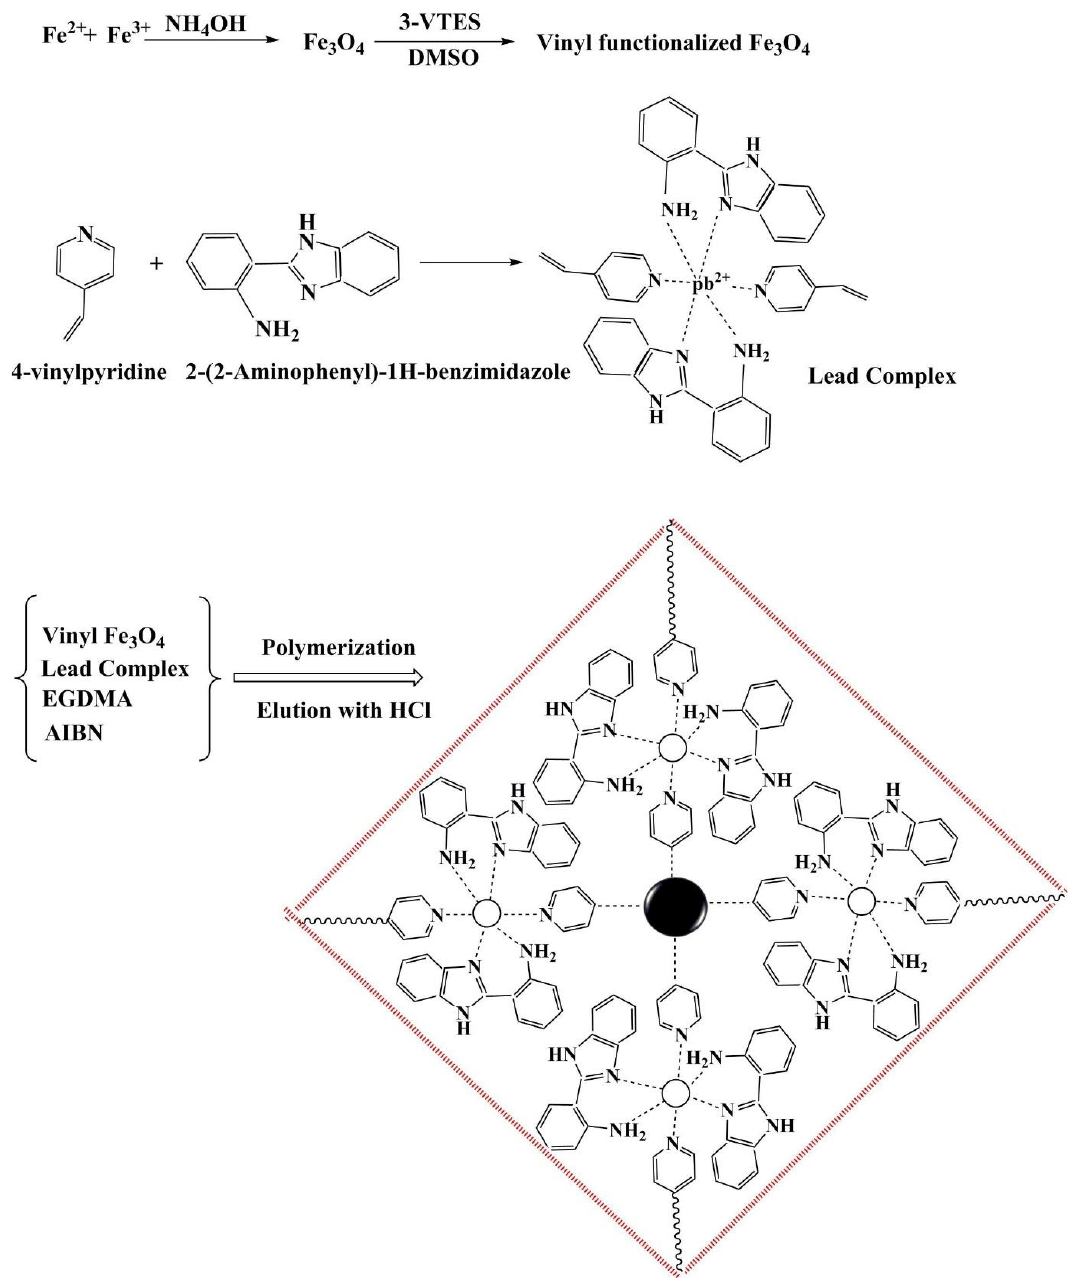
Figure 11. A schematic fabrication process of Fe 3 O 4 @SiO 2 @IIP. Adapted with permission from